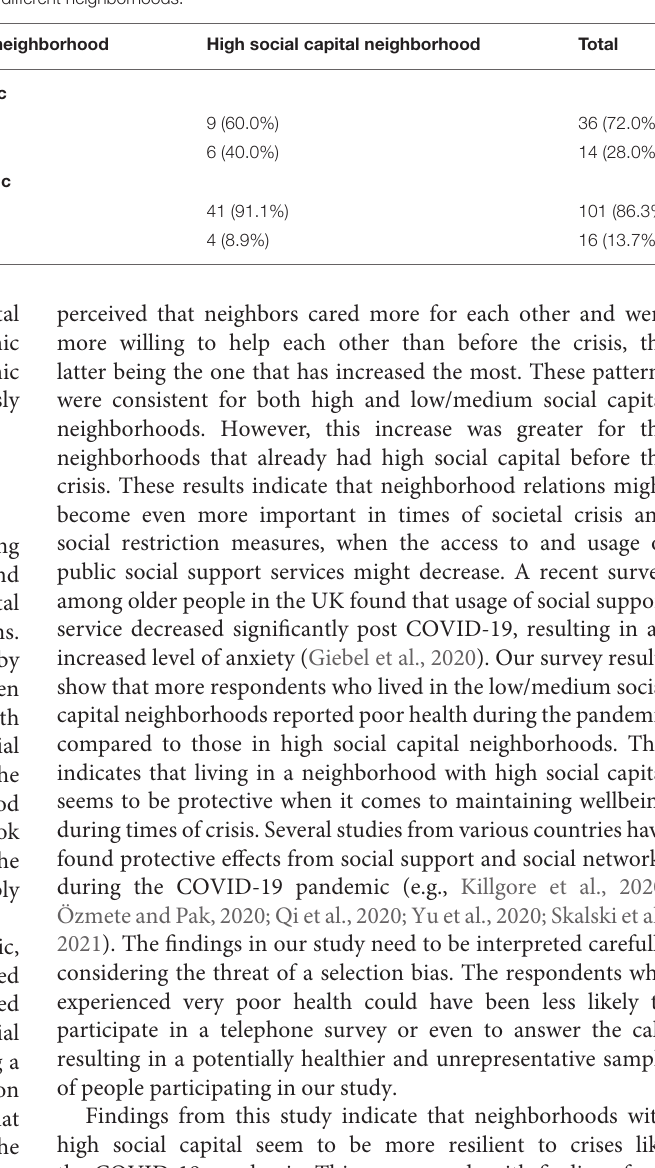
Perceived changes during COVID time—N (%) Low/medium social capital neighborhood High social capital neighborhood Total Less than Same as More than Less than Same as More than Less than Same as More than before before before before before before before before before